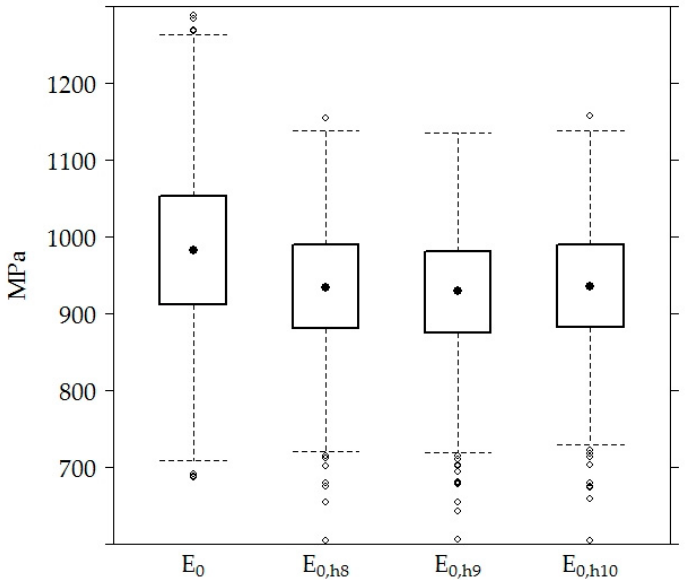
Figure 8. The box-plot of the surface and separate layer modulus of the road PS.